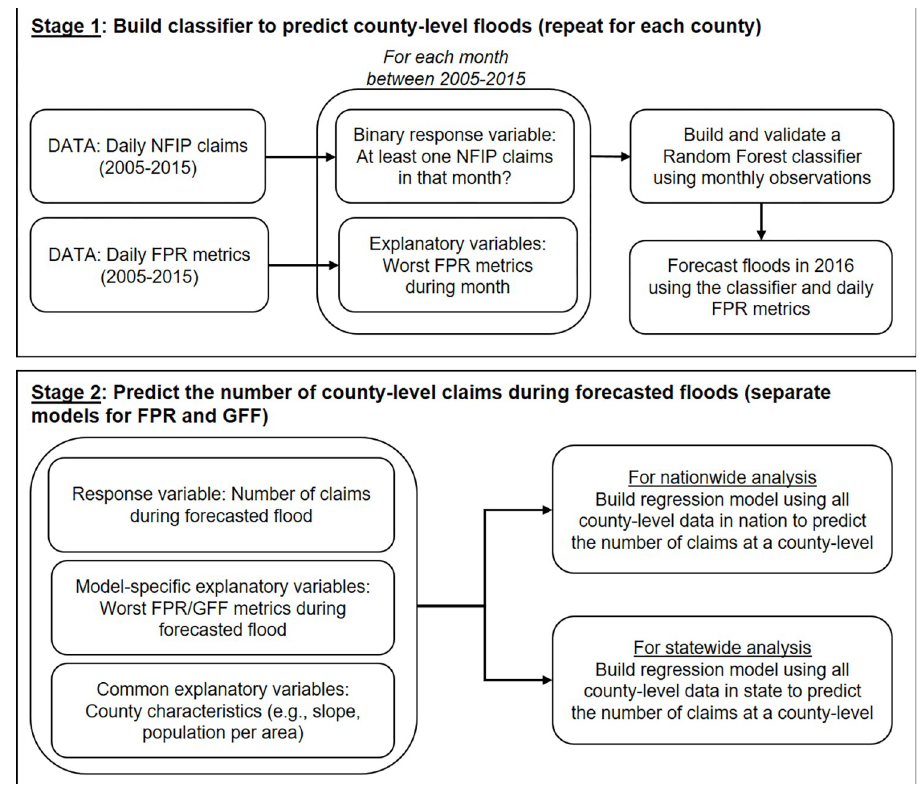
Fig 1. Framework of